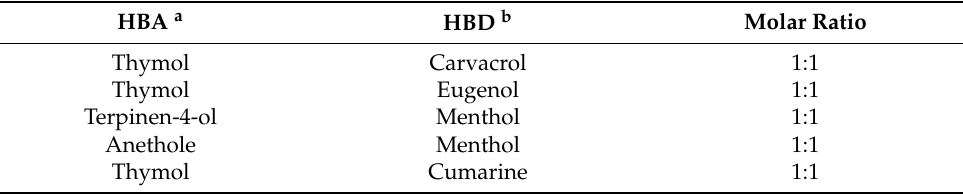
Table 1. List of the natural DESs prepared in this study. All HESs were prepared with the heat and stirring